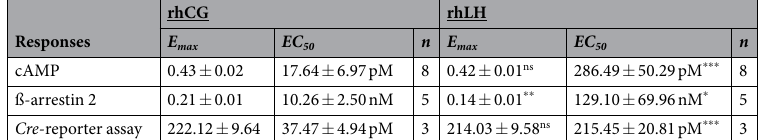
Table 1. Efficacy ( E max ) and efficiency ( EC 50 ) of rhCG and rhLH on LH/CGR measured in different assays in HEK293 cells. The E max values are represented as hormone-induced BRET changes (for cAMP and ß-arrestin 2) and relative luciferase activity × 10 3 (for Cre -reporter assay). Statistical analyses were performed with